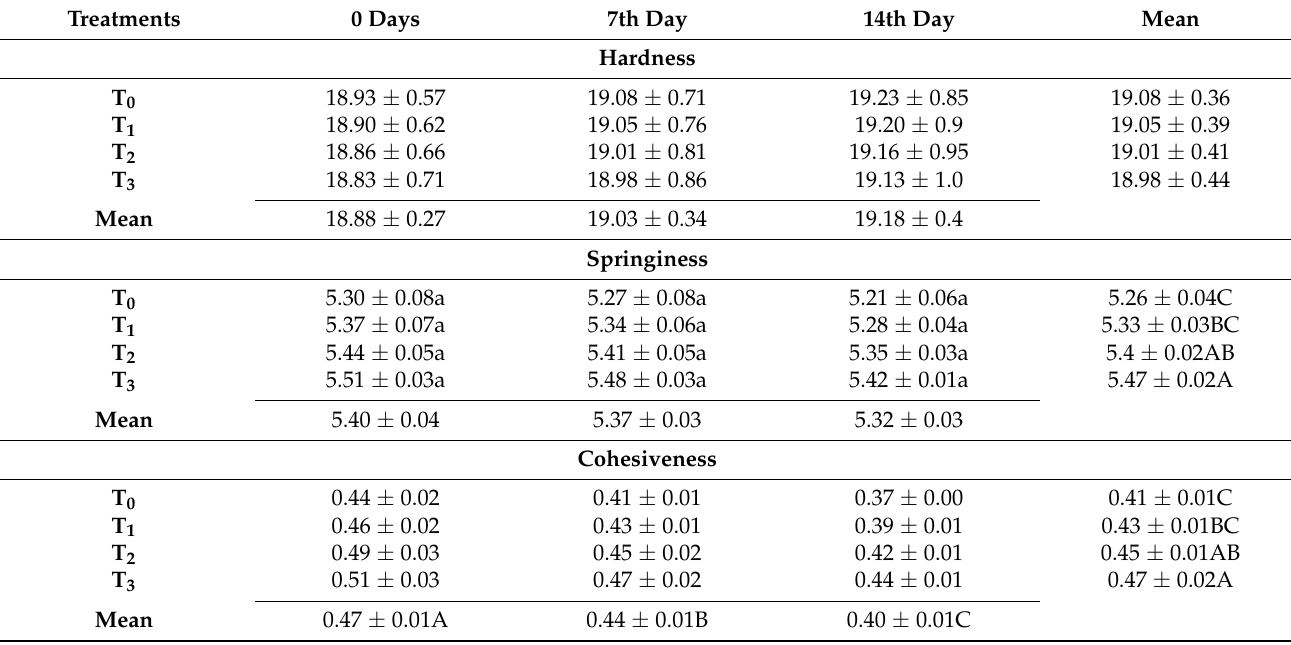
Table 8. Effect of O. basilicum essential oil supplementation on textural properties of chicken meat nuggets at refrigerated (4 ◦ C)